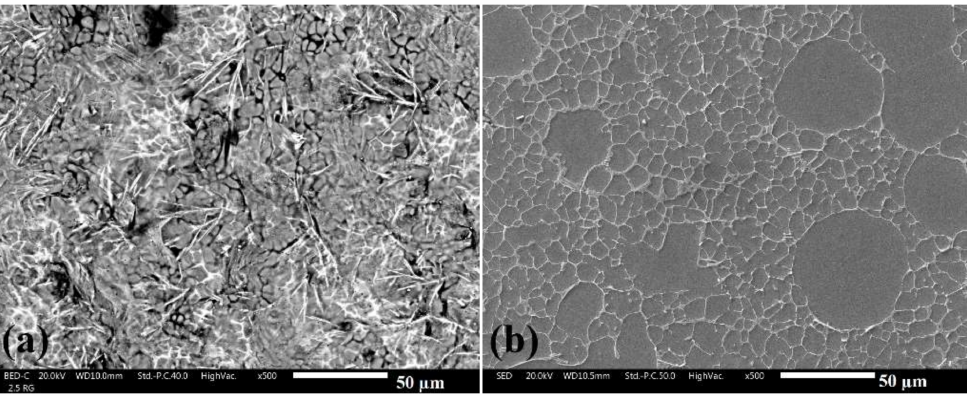
Figure 6. Scanning electron microscopy (SEM) image of sample ( a ) 2.5 RG (as-cast condition) and ( b ) 2.5 RGP (polished surface).